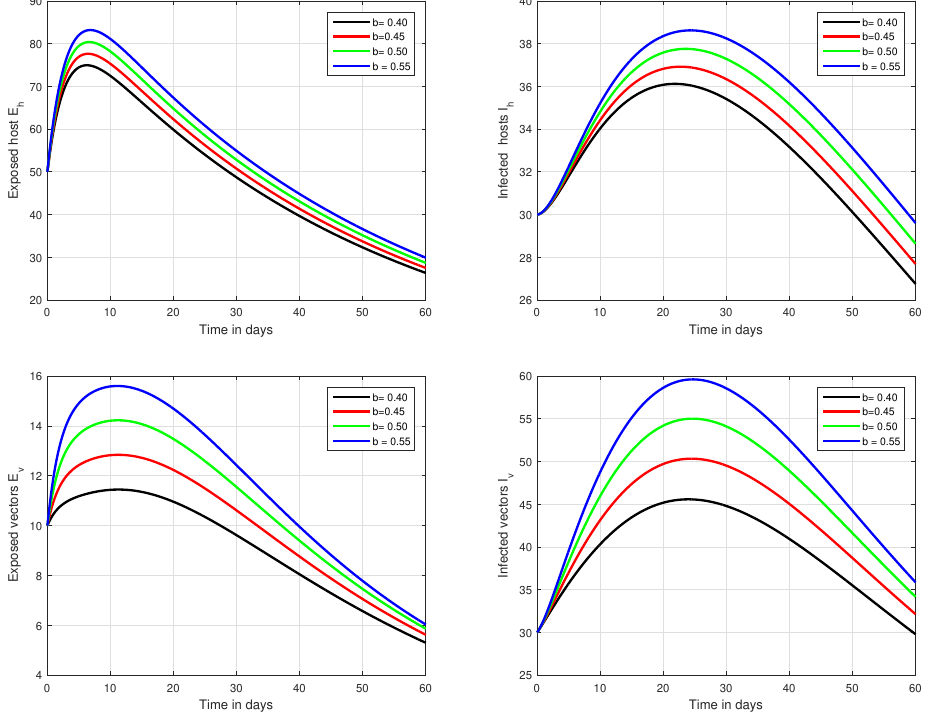
Figure 5. Graphical view analysis of the solution pathways of exposed and infected classes of our fractional system of Zika virus infection with various values of the parameter b , i.e., b =